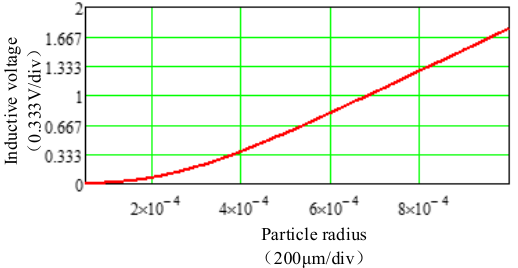
Figure 5. Relationship between the induced voltage and abrasive particle